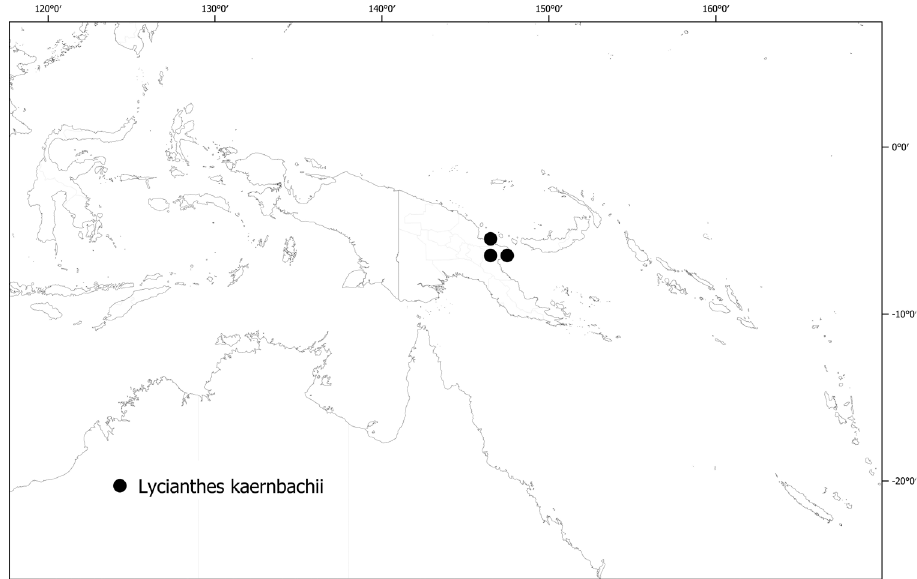
Figure 27. Distribution of Lycianthes